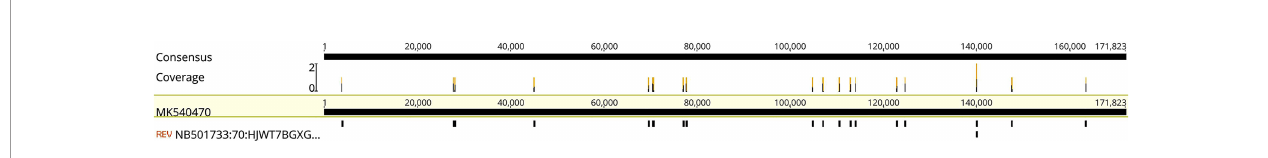
FIGURE 3 | Mapping results of EBV reads in cerebrospinal fl uid (CSF). Mapping results of EBVs in the CSF to EBV reference genome MK540470.